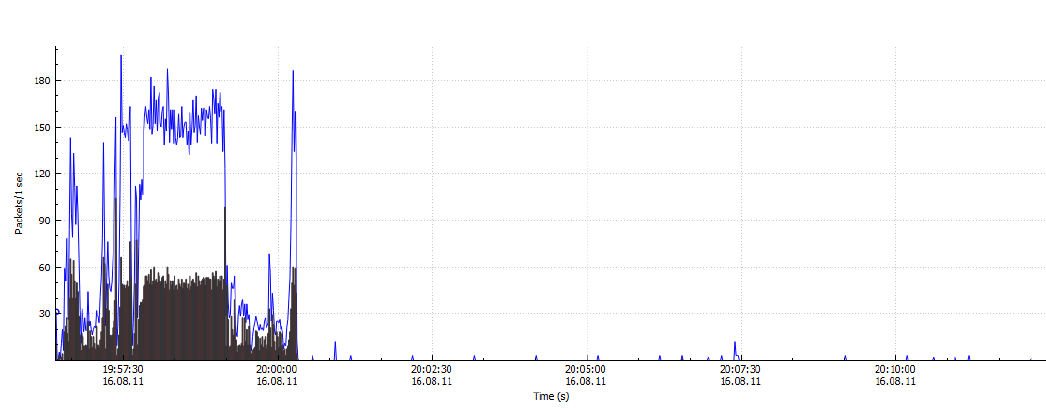
Figure 15. Sogou Botnet